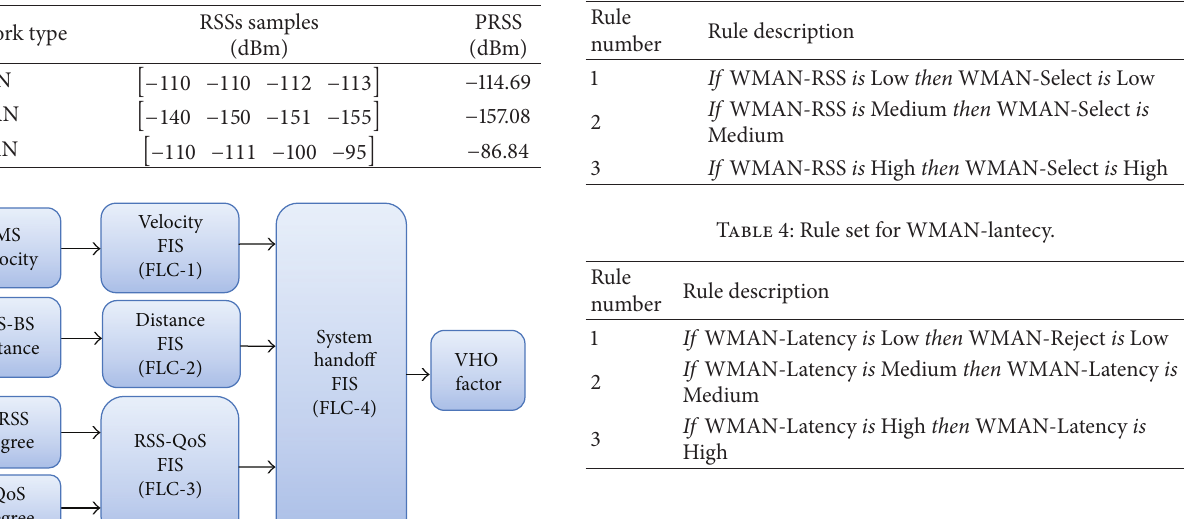
Table 2: PRSS using GPT.